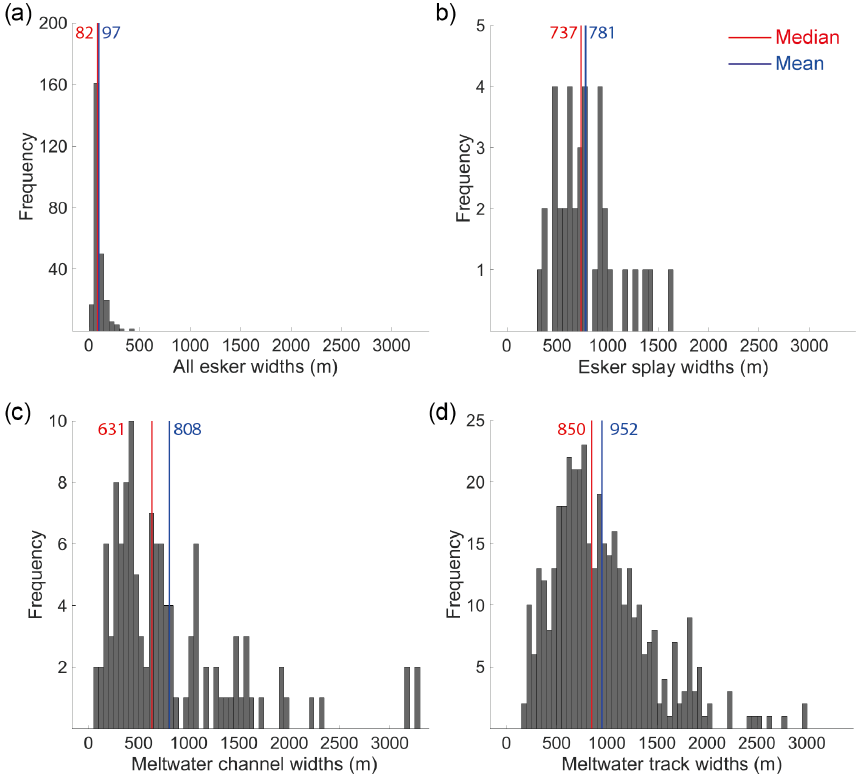
Figure 9. Width distributions (in metres) of (a) all esker ridges ( n = 259), (b) eskers with lateral splays ( n = 37), (c) meltwater channels ( n = 118) and (d) meltwater tracks ( n = 408) from the whole study area. The median is marked in red and the mean in blue.